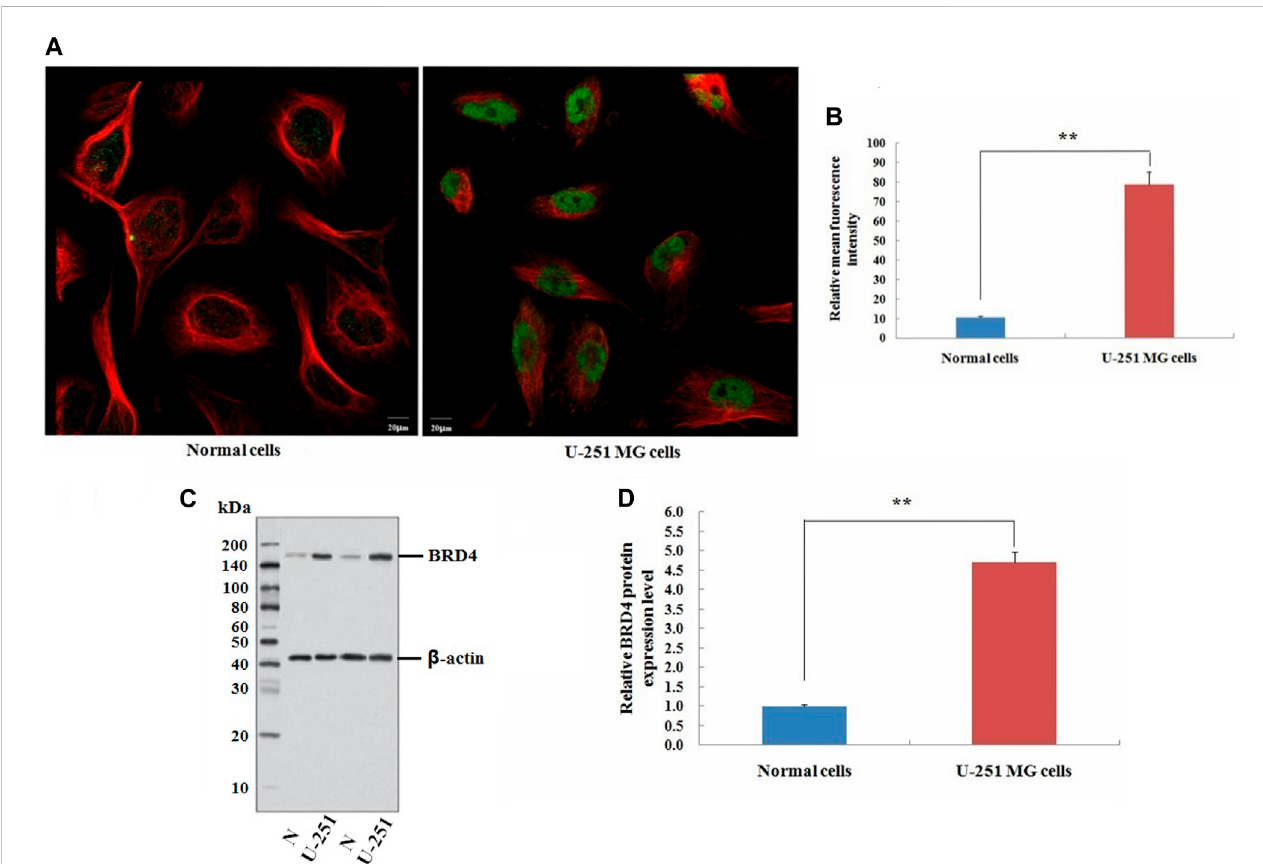
FIGURE 11 Validation experiment of BRD4 expression in cells. (A) Immuno fl uorescence analysis of BRD4 (green) in normal neuroglial cells and U-251 MG cells (Scale bar: 20 μ m). (B) Mean relative fl uorescence intensity values for each group. (C) Western blot analysis of BRD4 protein between normal neuroglial cells and U-251 MG cells. β -Actin was an internal control. (D) Relative expression value of BRD4 protein (means ± SD, n = 3,** p <